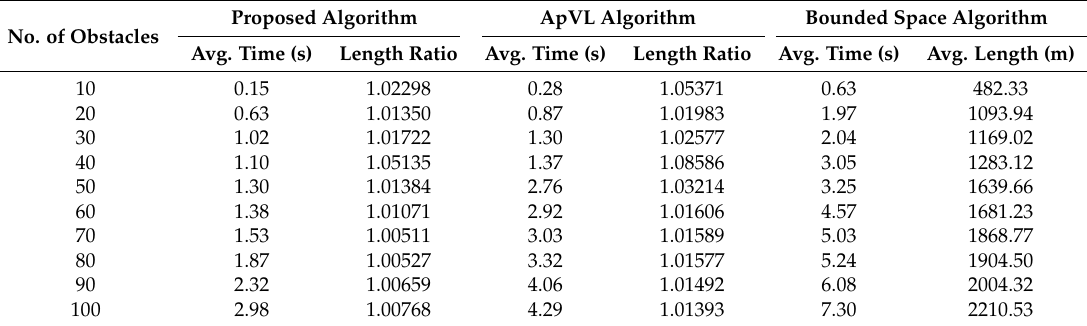
Table 2. Proposed algorithm pathfinding performance with varying number of obstacles.